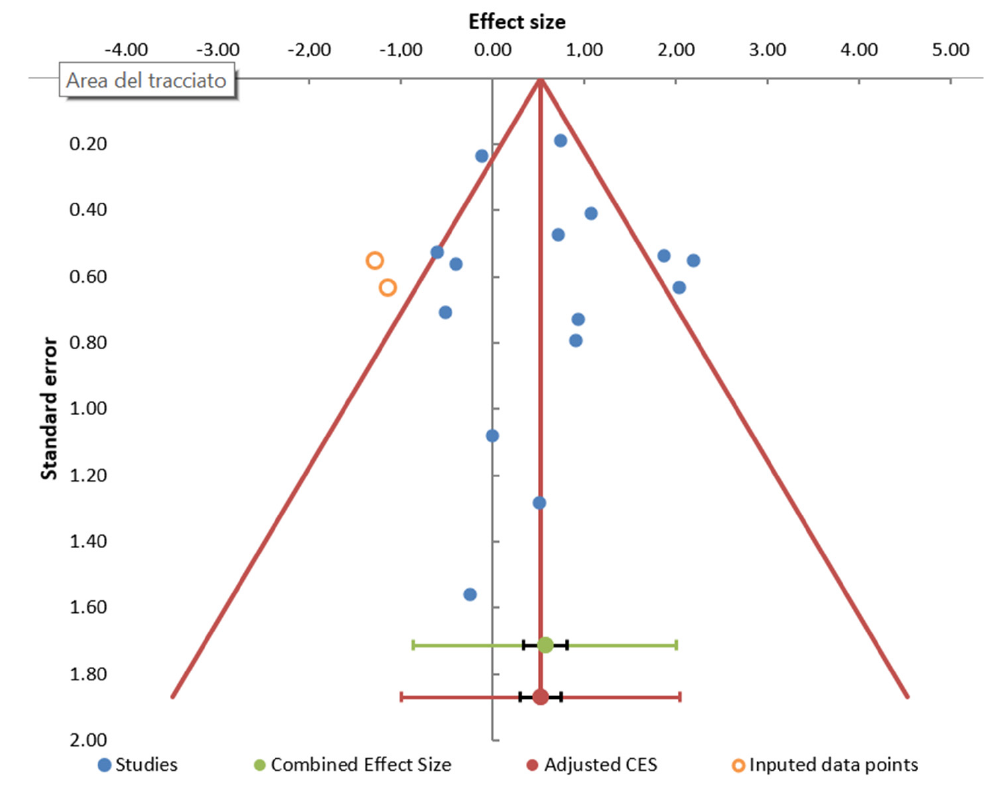
Figure 3. Publication bias. Funnel plot of studies reporting LD (diagnosed by antibodies) associated with occupational exposure.